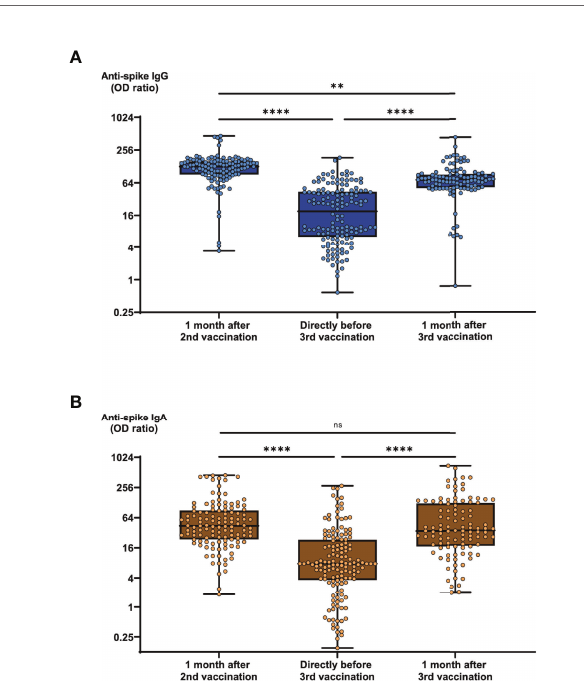
FIGURE 1 | SARS-CoV-2-speci fi c antibody response in COVID-19- convalescent individuals before and after booster vaccination. Serum samples from up to 147 subjects with con fi rmed COVID-19 history were collected one month after second vaccination with BNT162b2, 6 months after second vaccination (directly before third vaccination), and one month after third vaccination. Samples were then analyzed for anti-spike IgG and IgA titers. Box blots show (A) anti-spike IgG titers and (B) anti-spike IgA titers at different time points as indicated. Box central horizontal lines indicate medians, box borders represent IQR, whiskers indicate minima and maxima. Signi fi cance levels were **p < 0.005 and ****p < 0.00005. IQR, interquartile ranges; OD, optical density; ns, not signi fi